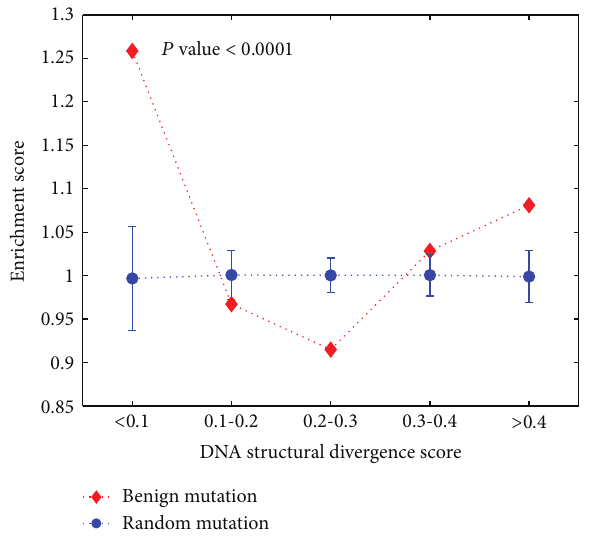
Figure 4: Benign mutations show extremly low DNA structural divergence.